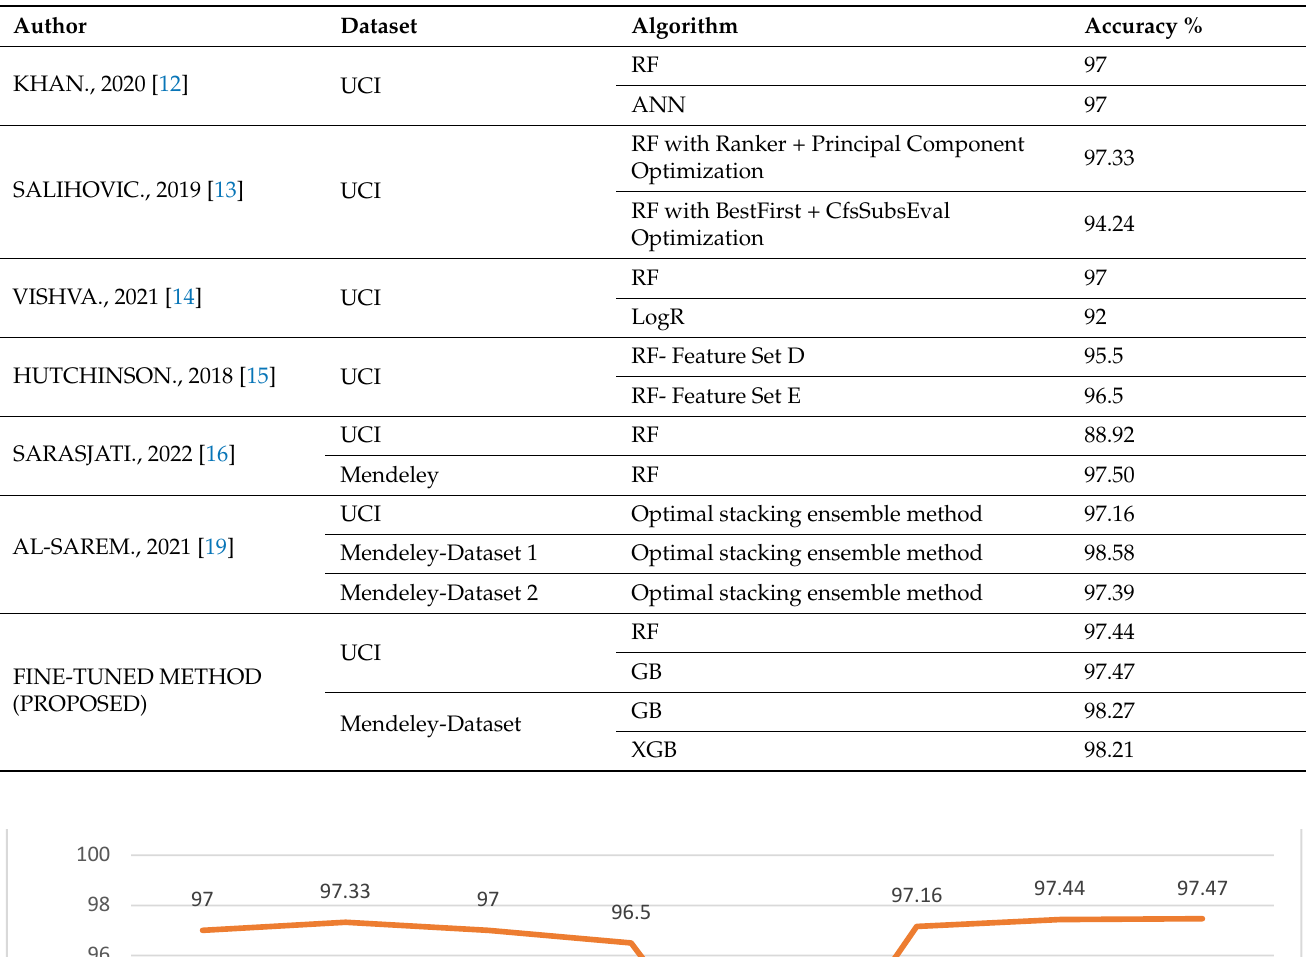
Table 18. Performance comparison of existing and fine-tuned method for Dataset-1 and Dataset-2.